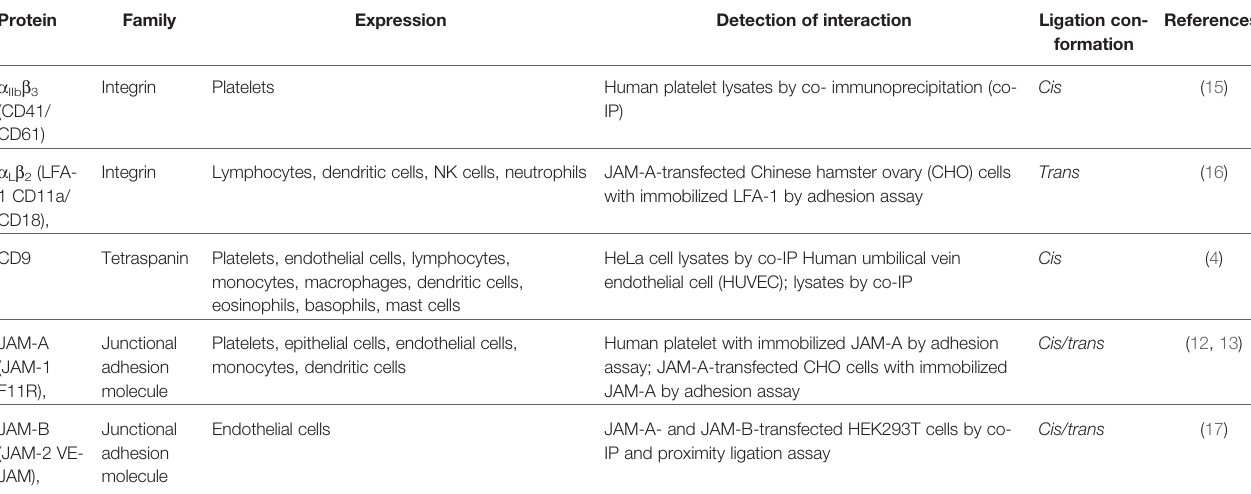
TABLE 1 | Junctional adhesion molecule-A (JAM-A) described extracellular ligands.